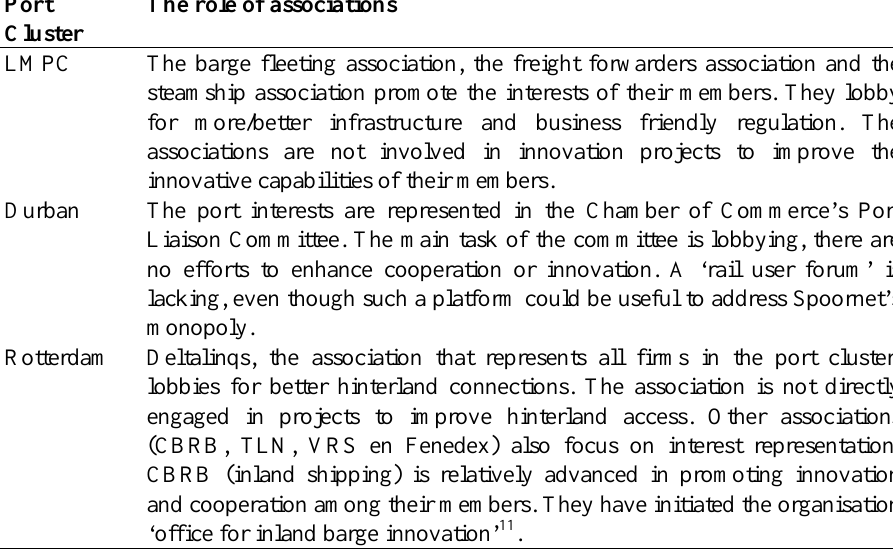
Table 10. The roles of associations in the HAR of the LMPC, Durban and Rotterdam Port The role of associations Cluster